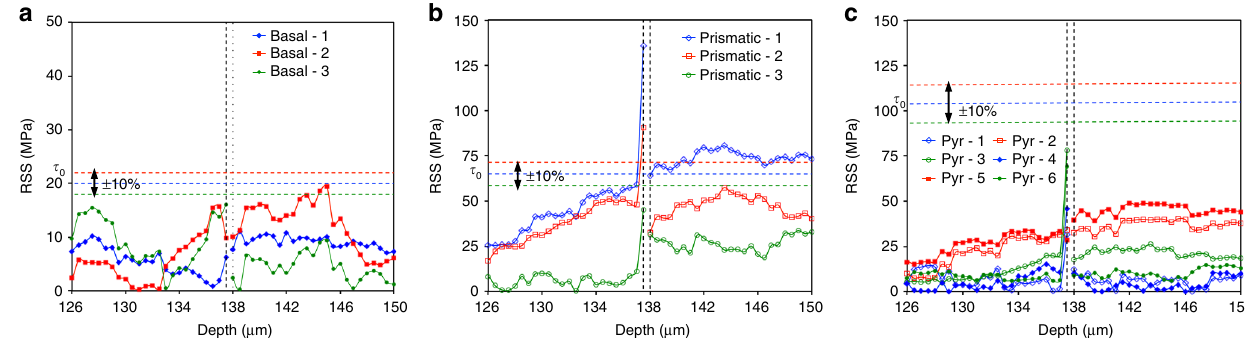
Fig 4 Asymmetric slip activity. Spatial distribution of resolved shear stress for ( a ) basal <a>, ( b ) prismatic <a>, and ( c ) pyramidal <c + a> slip modes. The critical resolved shear stress (CRSS) for each mode is shown with a 10% band to identify the activation of slip modes. Left side of the twin seems to completely elastic and on the right side only prismatic slip is possible deformation modes. The deformation of these two domains is, no doubt, in fl uenced by the surrounding grain neighborhood. The